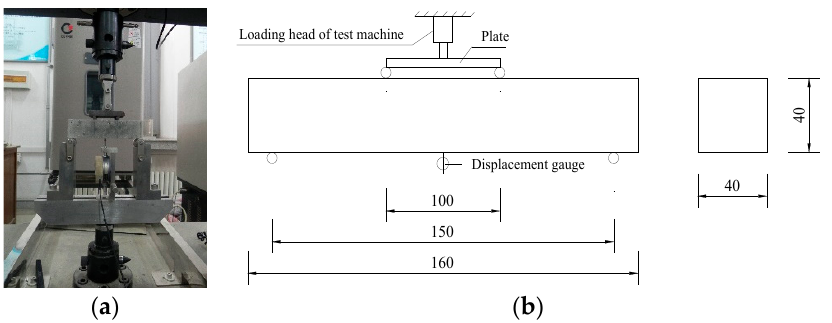
Figure 3 . Four-point flexural testing apparatus: ( a ) test apparatus; ( b ) loading diagram.